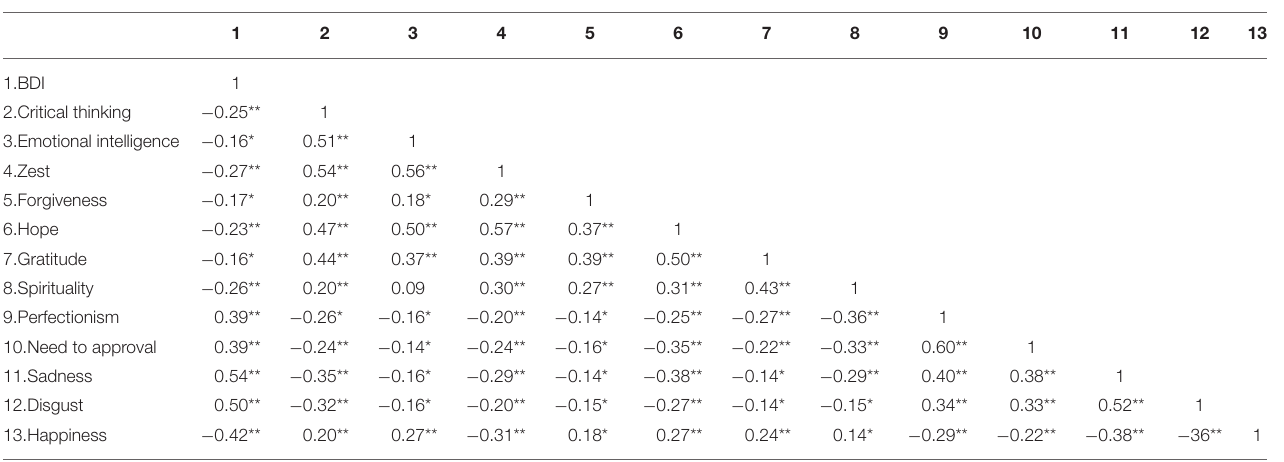
TABLE 2 | Zero–order correlations between the